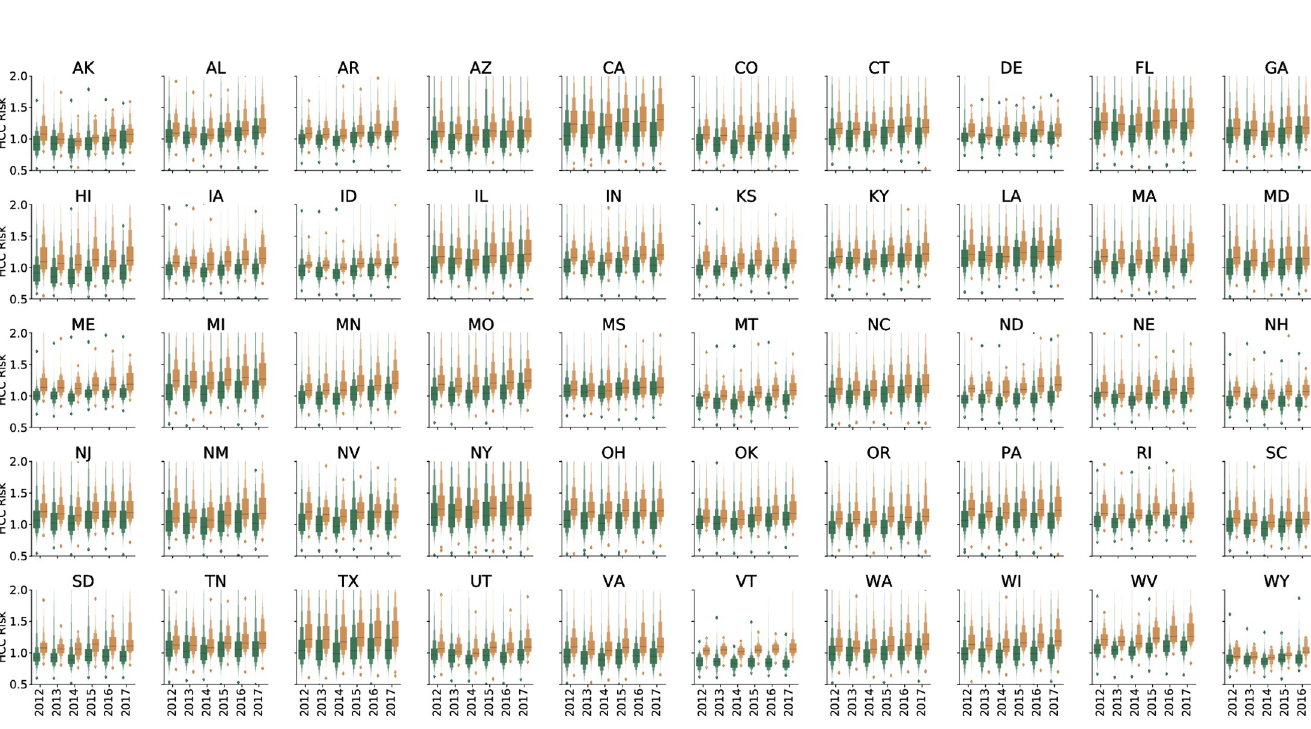
PLOS ONE | https://doi.org/10.1371/journal.pone.0227783 September 14, 2020 6 /